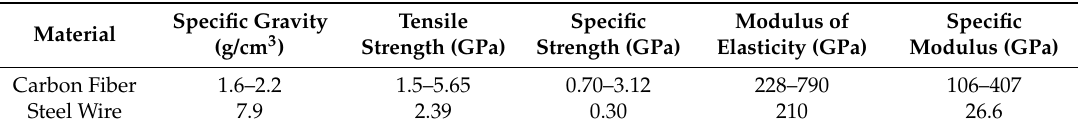
Table 1. Specific Properties for Carbon Fiber and High-Strength